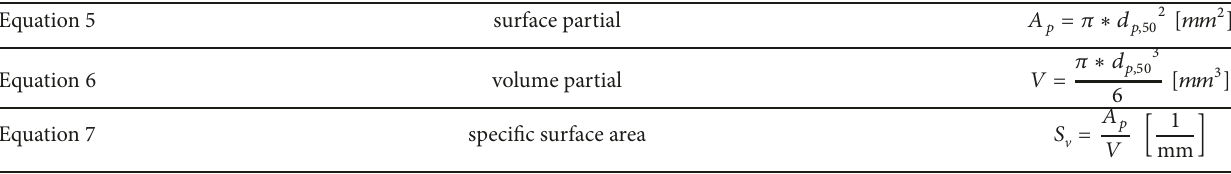
Table 2: Overview of equations for the mean particle size.